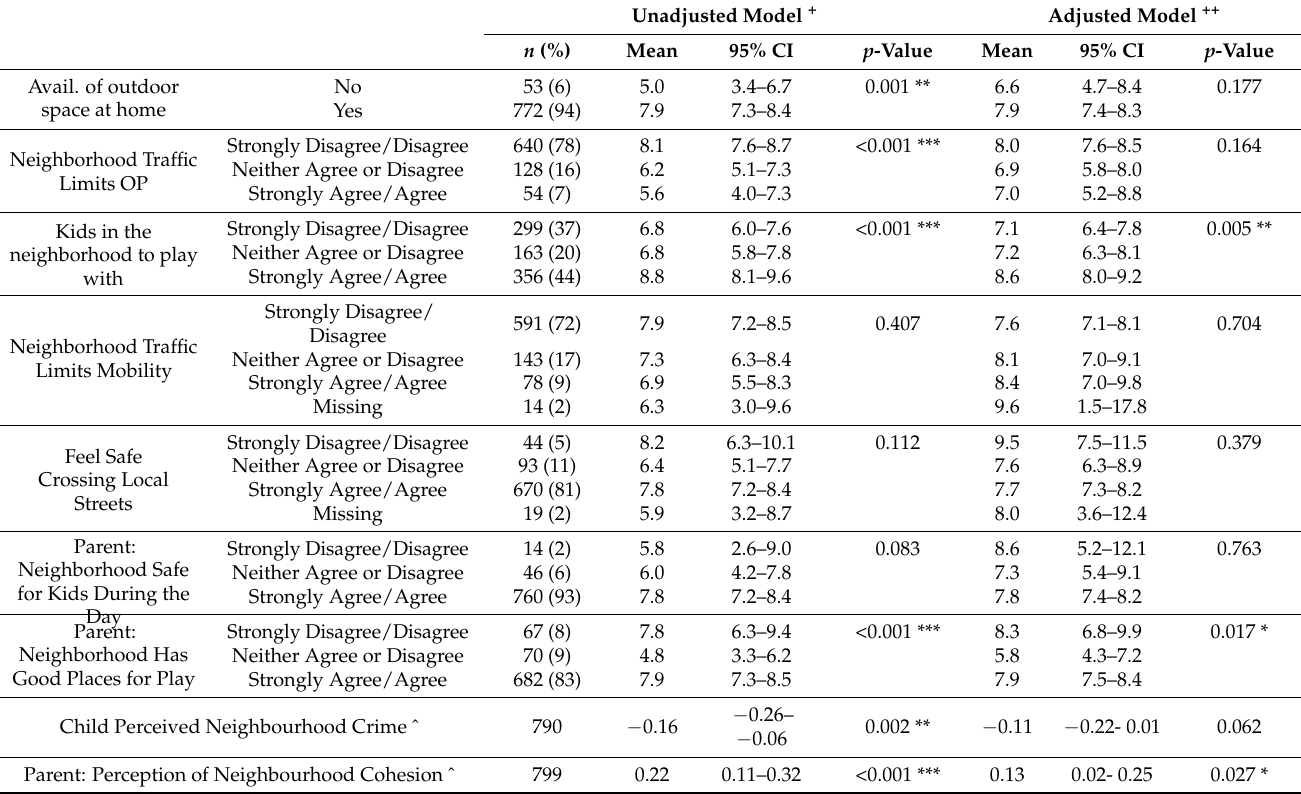
Table 6. Socio-environmental Supports for Outdoor Play: Descriptives and Model 4 Results. Adjusted model controls for demographic variables in Model 1 (Table 3) 1